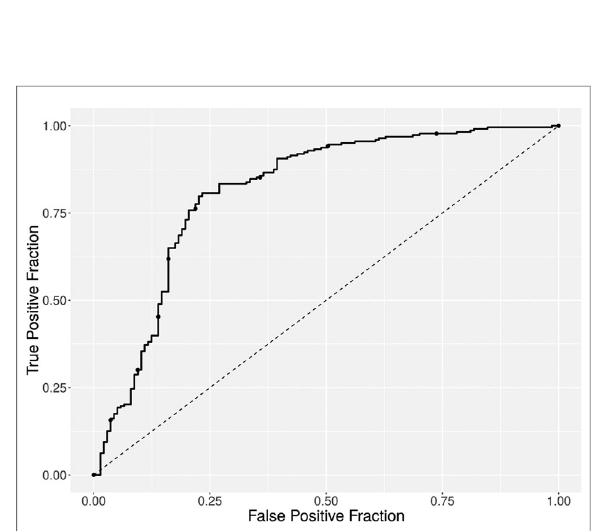
FIGURE 9 Scatterplot of the number of principal components necessary to explain 90% of the variance (dimensionality) calculated for 10 frequencies of attenuation. Each point represents a measurement of a patient at a given time; the points are colored according to their respective SOFA score.